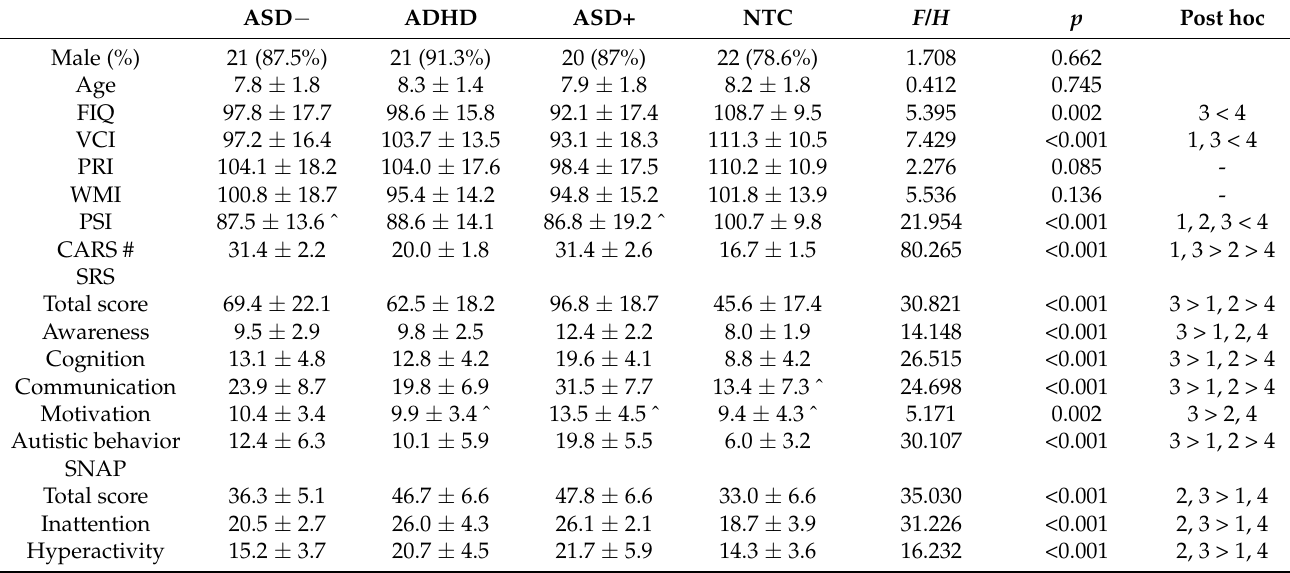
Table 1. Demographic characteristics of the participants (n =